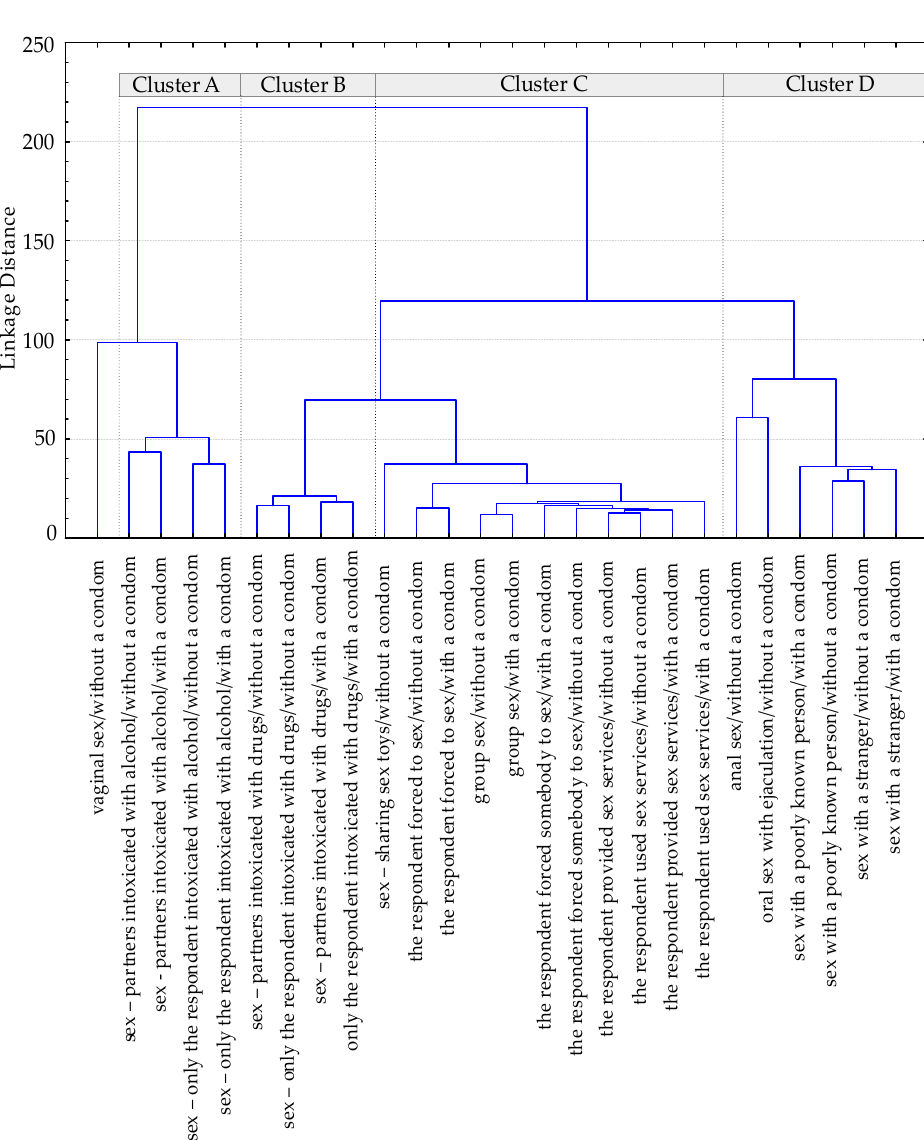
Figure 1. Risky sexual experiences clusters.